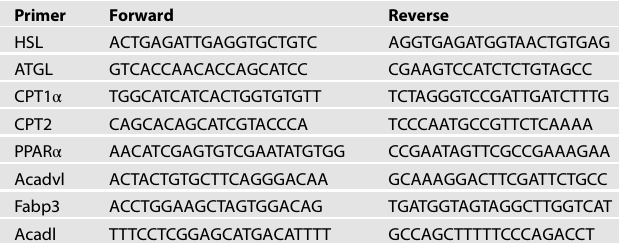
Table 1. Primer sequences for real-time PCR (RT-PCR)